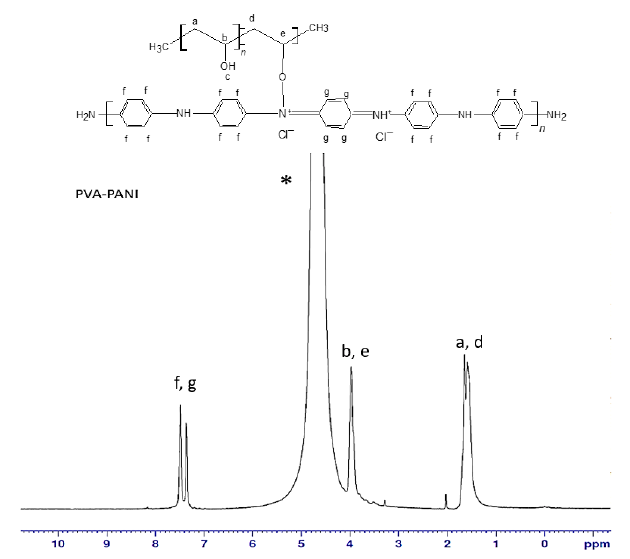
Figure 1. 1 H-NMR spectra for PVA–PANI in D 2 O (*).